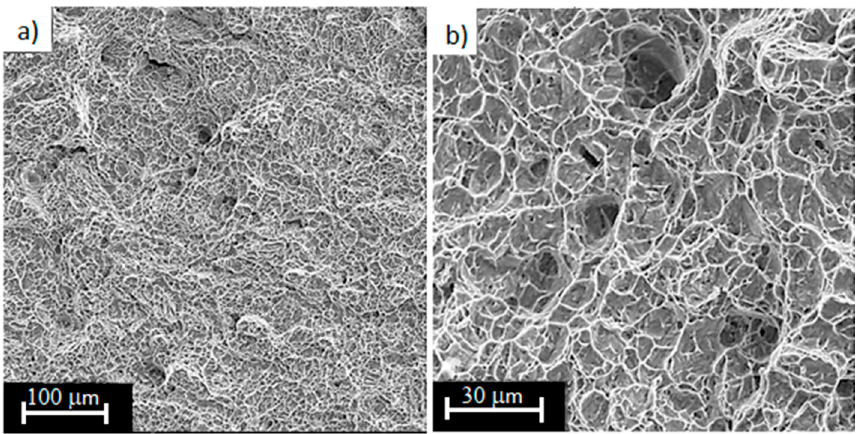
Figure 14. Fracture surfaces of Ti6Al4V titanium alloy with near-zero porosity, subjected to a monotonic tensile test (magnification: ( a ) 500×; ( b ) 2000×).